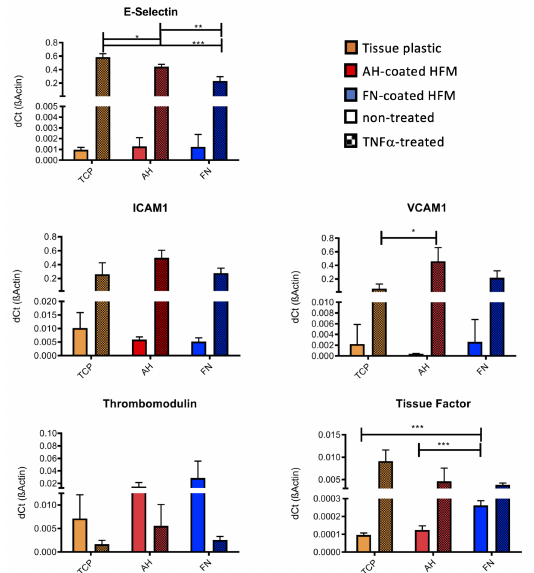
Figure 3. Gene expression analysis for EC activation state detection by realtime qRT PCR. Expression levels of endothelial specific activation markers of ECs cultivated on TCP, AH and FN coated HFM with and without TNF α treatment (* p < 0.05, ** p < 0.01, *** p < 0.001).